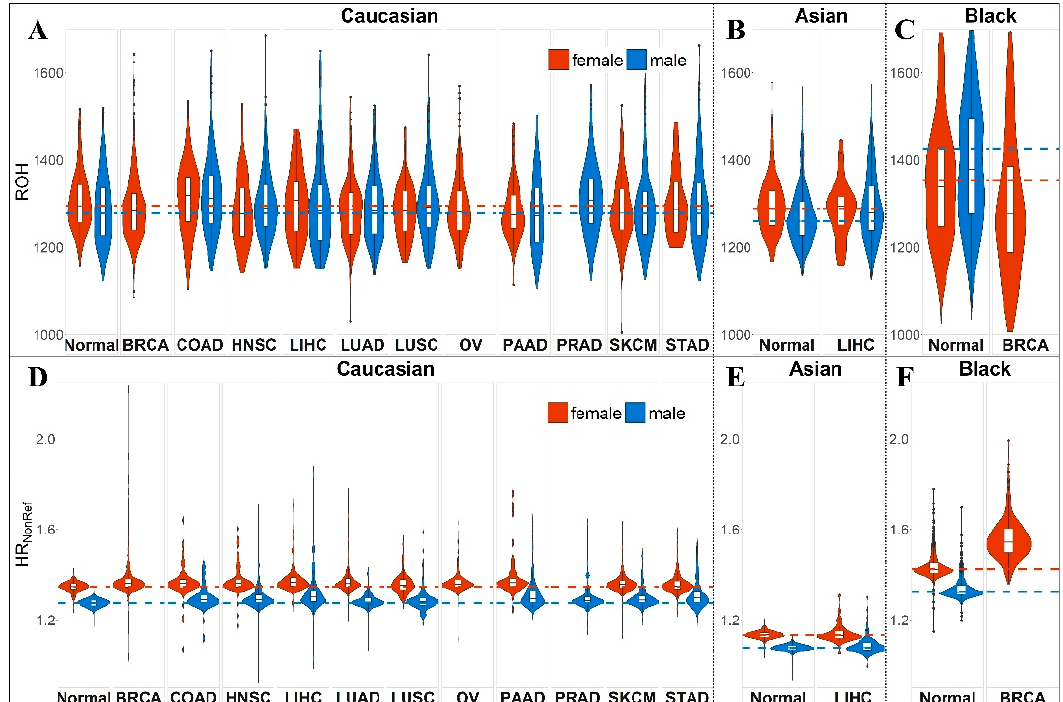
Figure 3. Comparison of HR NonRef and ROH between sex across all three races tested. The computation of HR NonRef and ROH contains sex chromosomes X and Y. For the equivalent of this figure without chromosomes X and Y, please see Figure S2. ( A ) Violin and boxplots of ROH separated by sex for Caucasians. ( B ) Violin and boxplots of ROH separated by sex for Asians. ( C ) Violin and boxplots of ROH separated by sex for Blacks. ( D ) Violin and boxplots of HR NonRef separated by sex for Caucasians. ( E ) Violin and boxplots of HR NonRef separated by sex for Asians. ( F ) Violin and boxplots of HR NonRef separated by sex for Blacks. Females, in general, have higher HR NonRef than males and the difference is substantially more visible than ROH.